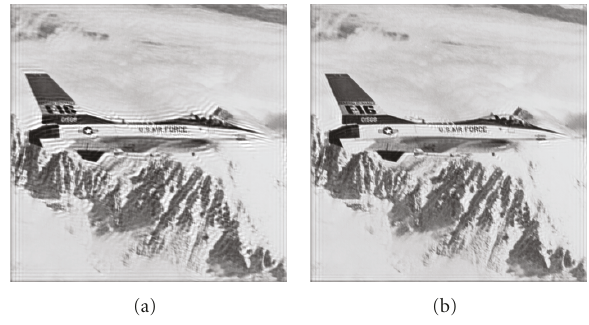
Figure 12: Restoration results of numerically blurred image where the PSF is estimated after 40 updates. (a) Restored image by using the conventional algorithm [7]. (b) Restored image by using the proposed.